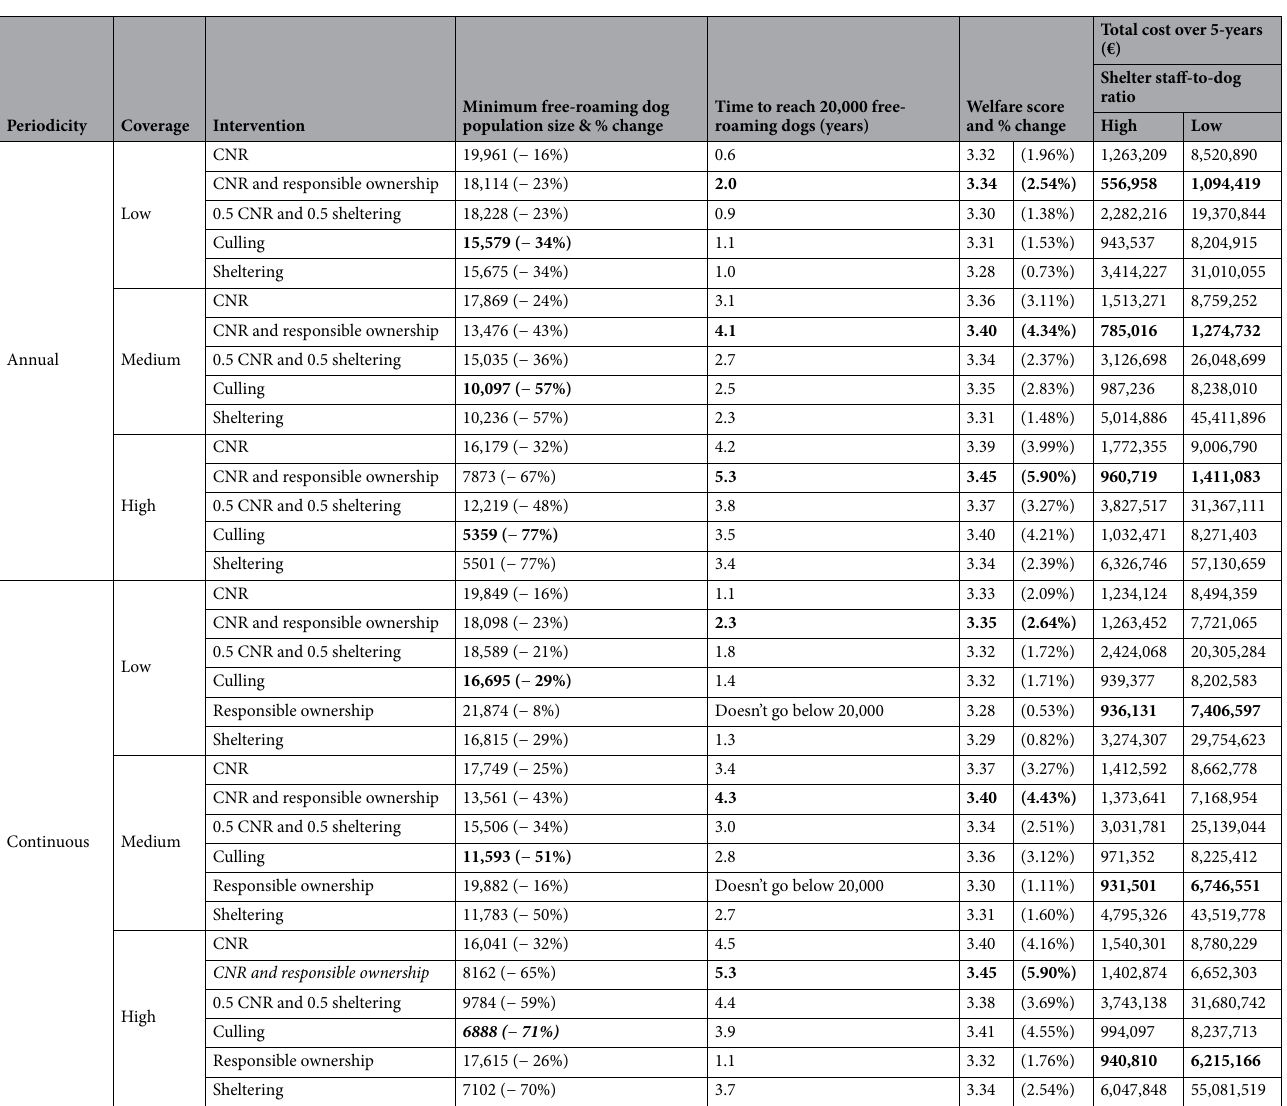
Table 5. Impact of five-year intervention on minimum free-roaming dog population size and time taken between end of intervention and free-roaming dog population size reaching 20,000 dogs. The intervention with the overall longest time to reach baseline population size is highlighted in italics. The intervention with the greatest reduction in free-roaming dog population size, the longest time to reach baseline population size, the greatest increase in welfare score, and the lowest cost for each periodicity-coverage combination are highlighted in